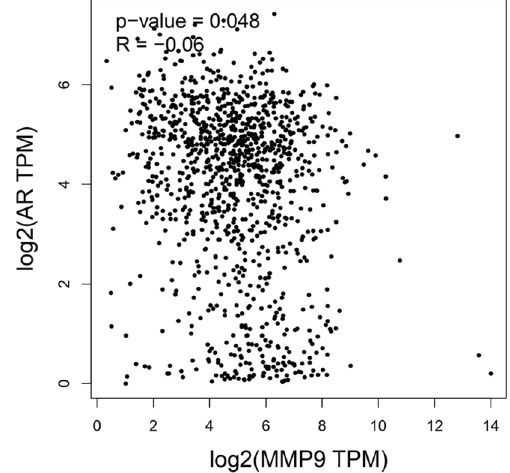
Fig. 8 Pearson correlation between the expressions of MMP9 and AR in the patient dataset BRCA deposited in TCGA. This figure was generated using online software GEPIA (http:// gepia. cancer- pku.